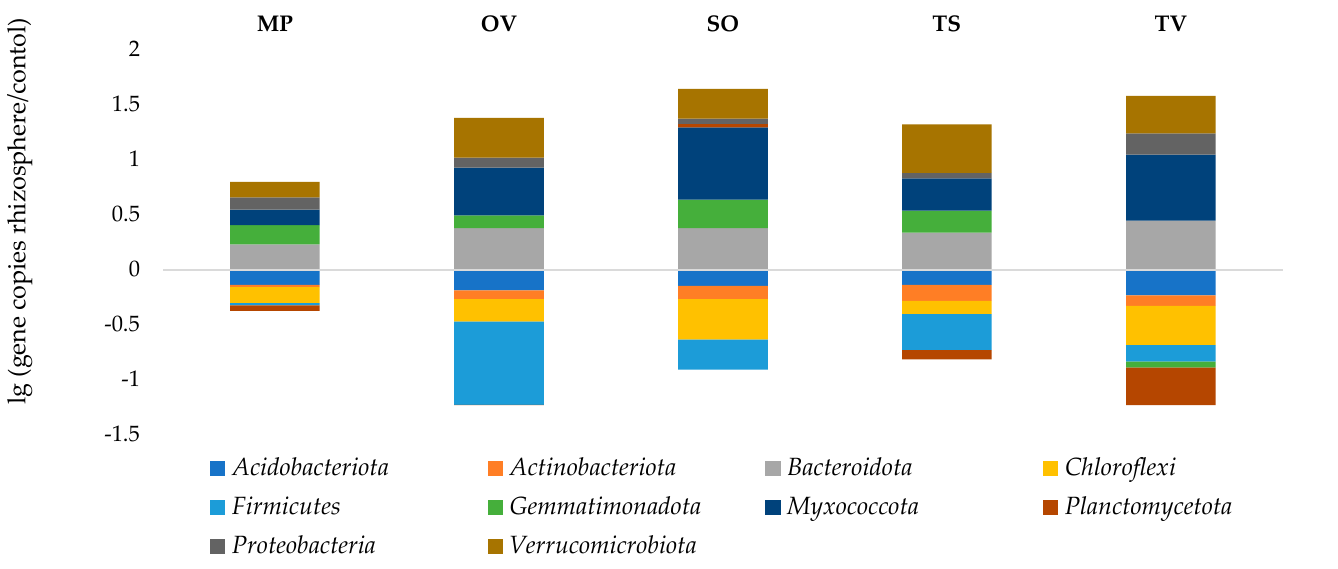
Figure 4. Rhizosphere effect. MP is peppermint ( M. piperita L.), OV—oregano ( O. vulgare L.), TV— Table 2. Diversity indices of microbial communities in Lamiaceae L. medicinal plants rhizosphere. Plot Type